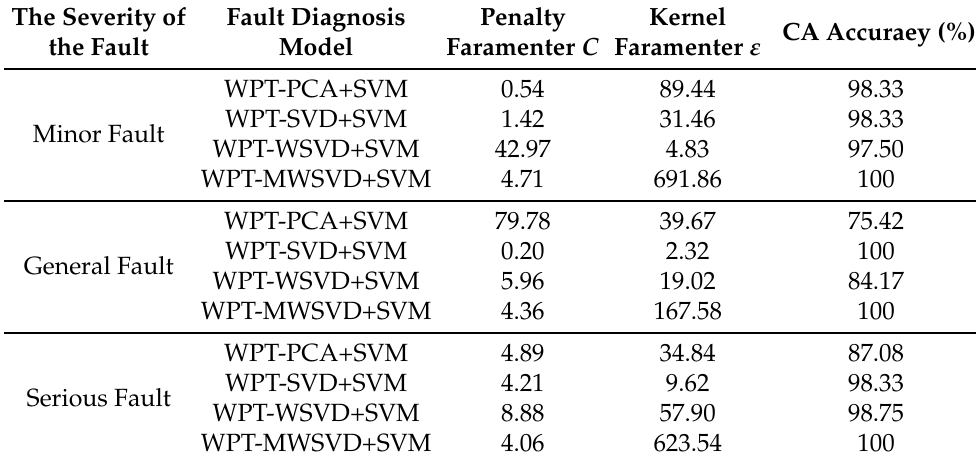
Table 6. The optimal parameters of Support Vector Machine